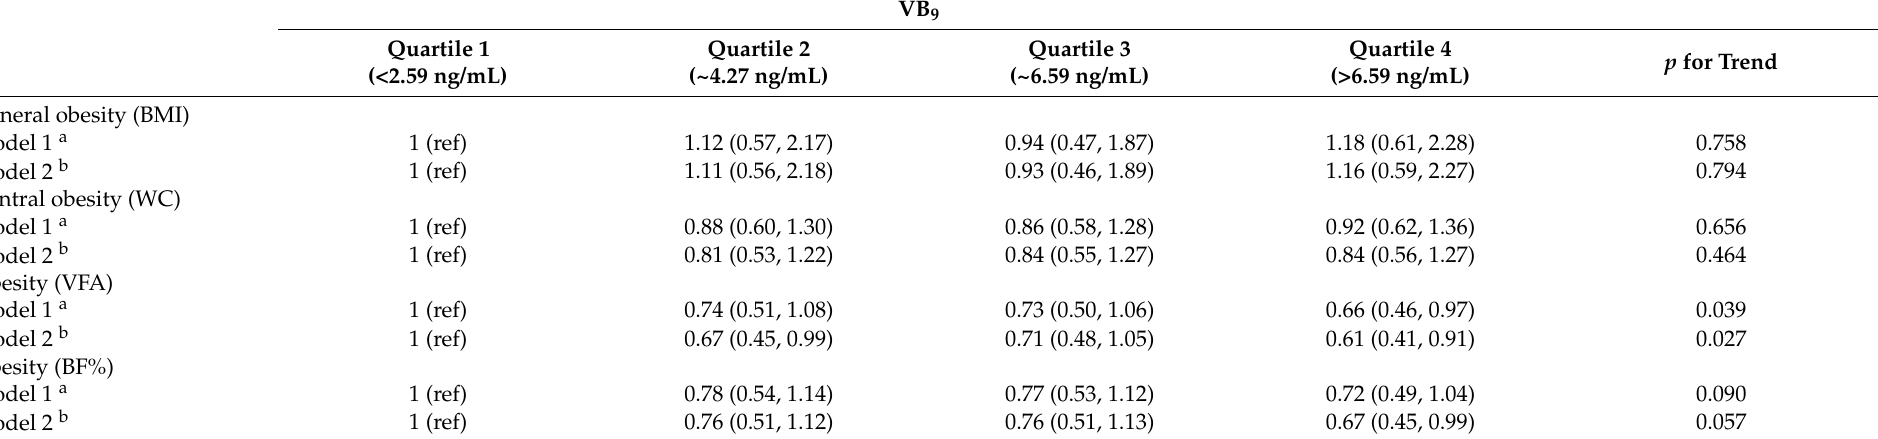
Table 7. Association between vitamin B 9 and obesity according to different obesity